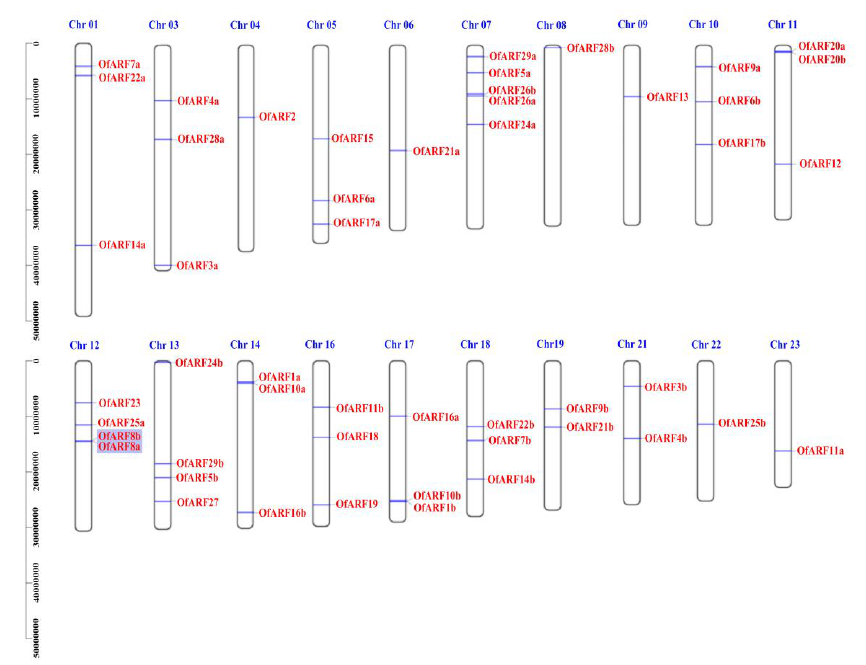
Figure 6. Distribution of auxin response factor genes ( OfARF s) on Osmanthus fragrans chromosomes. The chromosome number is indicated at the left of each chromosome. The scale is in bases Chr01–Chr23 are abbreviations for chromosome numbers 01–23, and blue rectangles refer to gene pairs of tandem duplications. Forests 2020 , 11 , x FOR PEER REVIEW